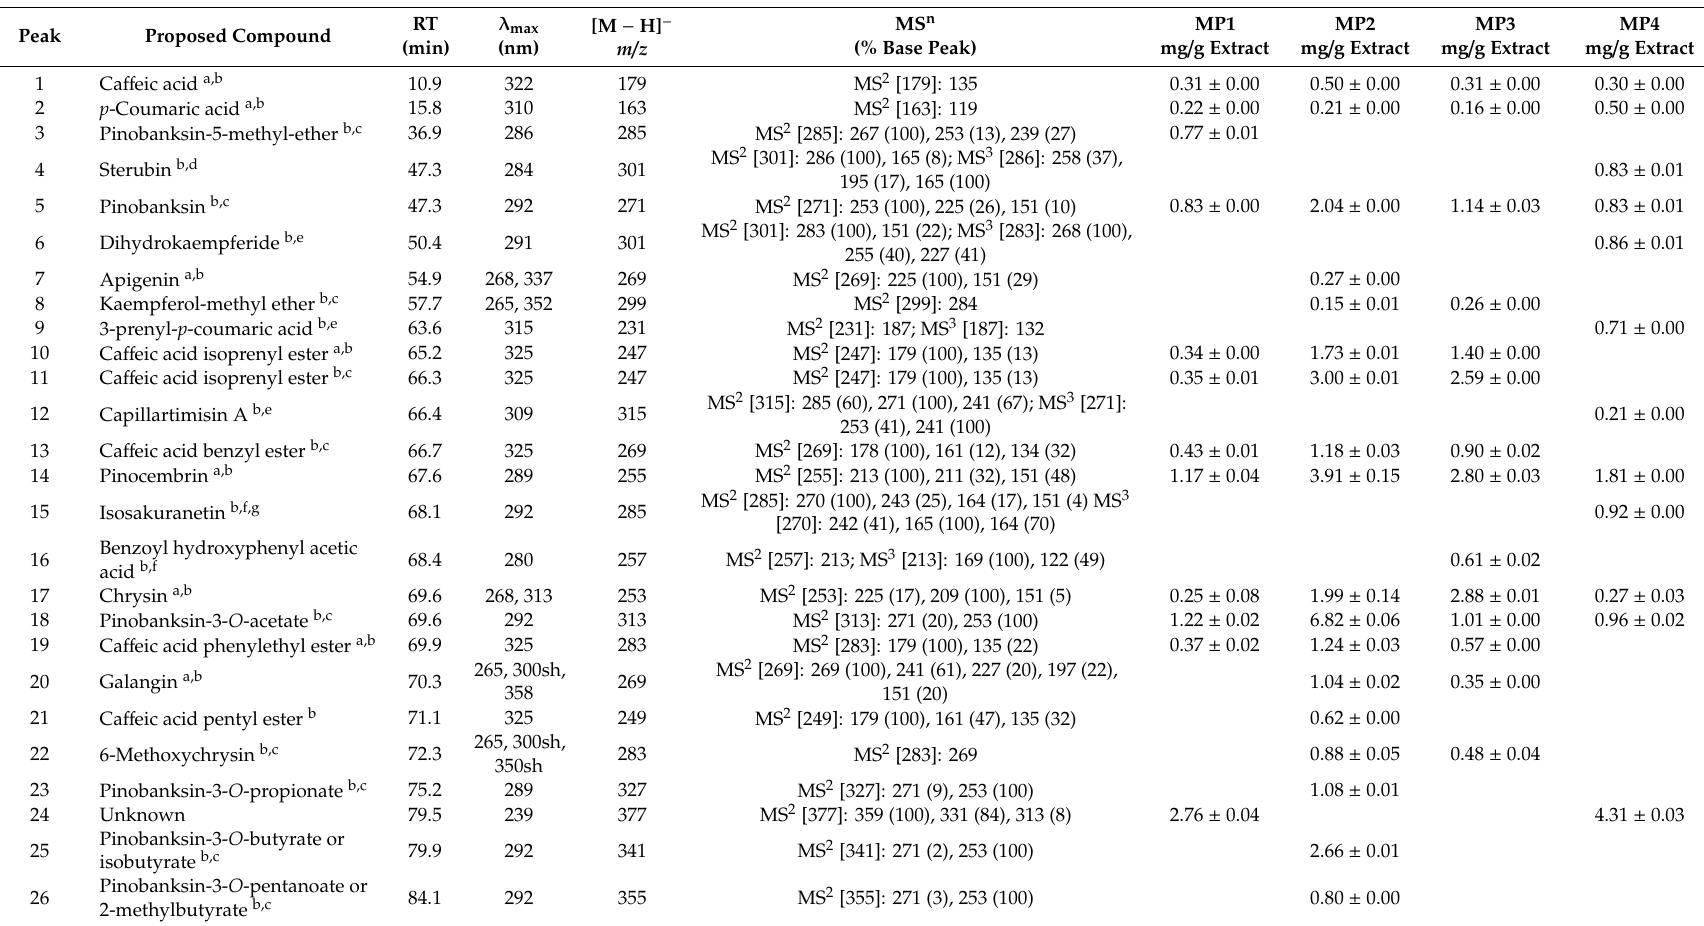
Table 1. Phenolic compounds in Moroccan propolis identified and quantified by LC / DAD / ESI-MS n (each value is the mean ± standard deviation, n =